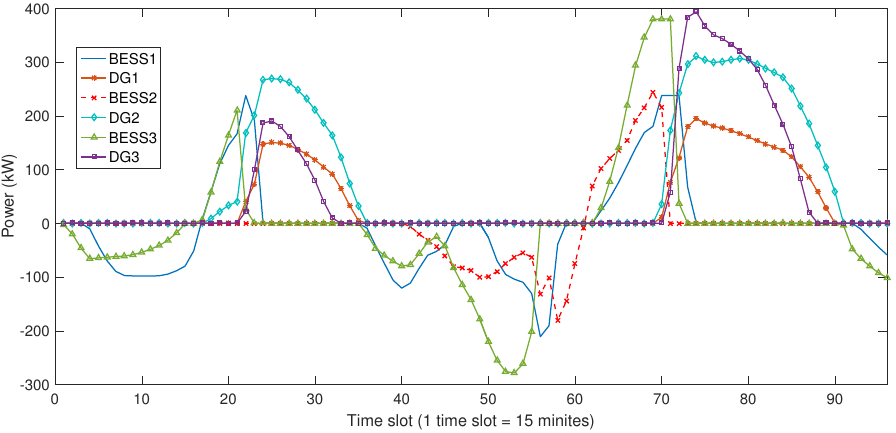
Figure 8. Scheduling results of the controllable DERs using the distributed optimization.